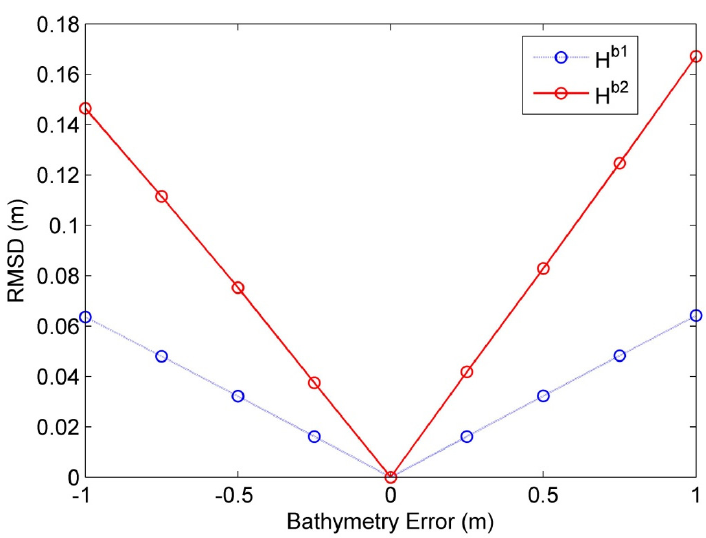
Figure 9. Results of the modeled water elevations at locations b1 and b2 to uncertainty in river bathymetry, varying from − 1 m to 1 m in steps of 0.25 m at the bench mark resolution 50